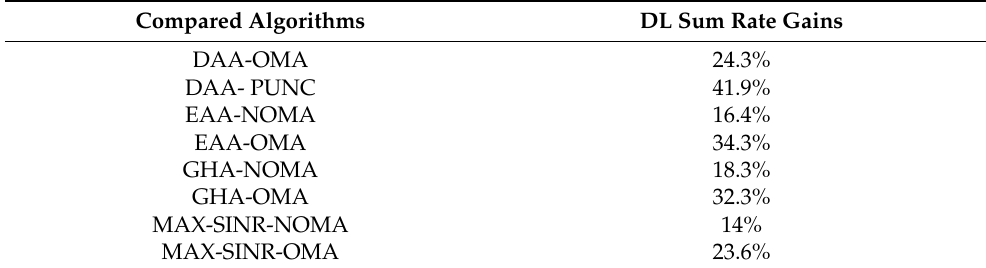
Figure 8. The DL total throughput for eMBB UEs versus number of eMBB UEs. ( a ) Ґ nm be > Ґ nm bl . ( b ) Ґ nm bl > Ґ nm be . Table 5. DL Sum Rate gains for eMBB